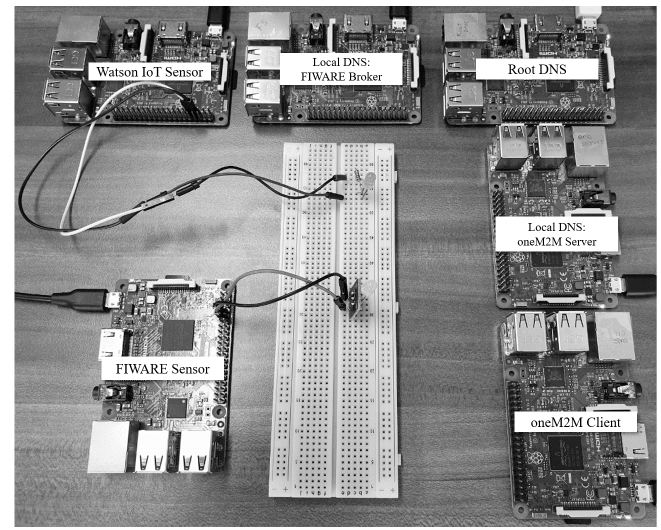
Figure 11. Implementation testbed.